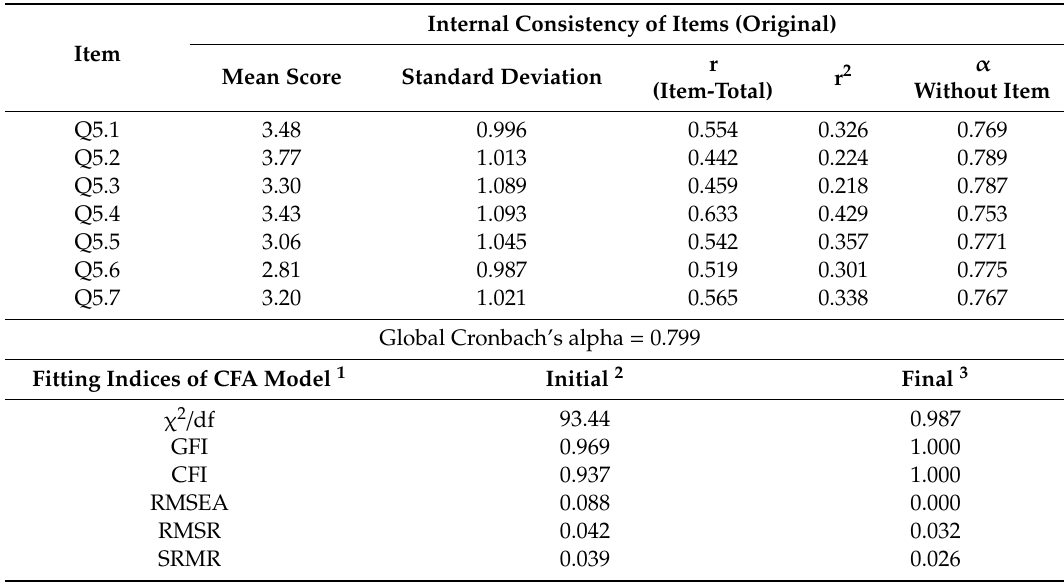
Table 5. Statistics for the unidimensional model of the scale about environmental and political motivations.